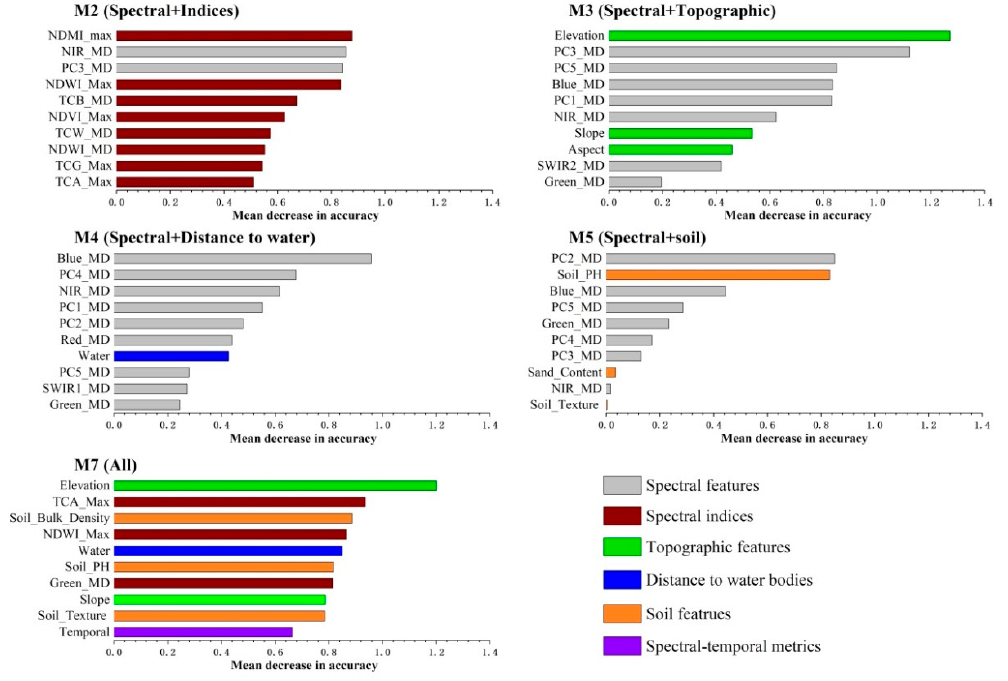
Figure 4. Most important features in the pixel-based models.